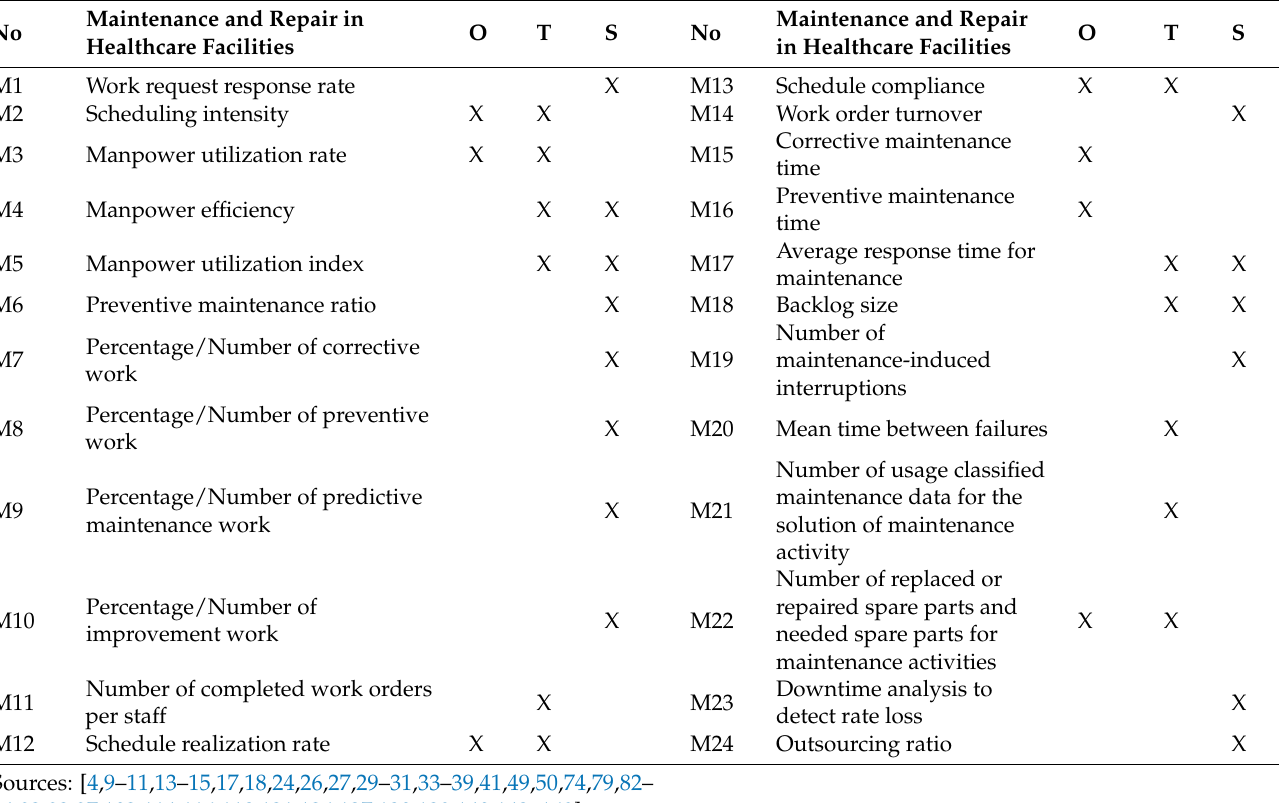
Table 4. FM KPIs for maintenance and repair in healthcare facilities (O: operational, T: tactical, S: